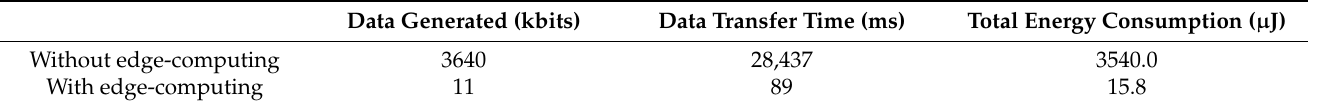
Table 1. Comparison of energy savings in the wireless module with and without edge-computing for a complete sequential scan